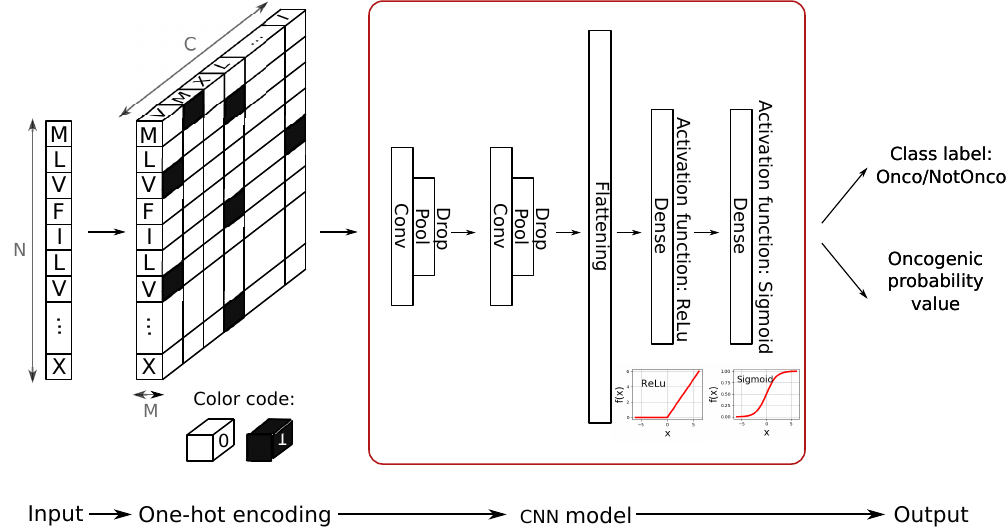
Figure 4. Proposed solution: from input sequence to classification outcomes (class label and oncogenic probability